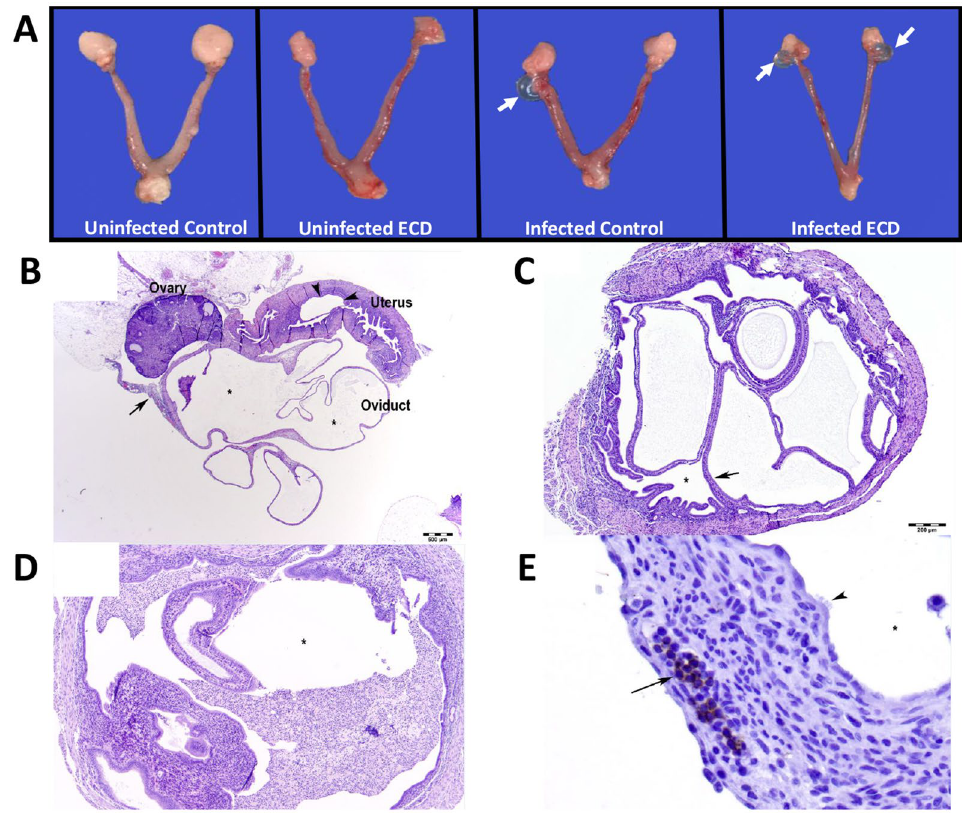
Figure 1. A correct version of the original Figure